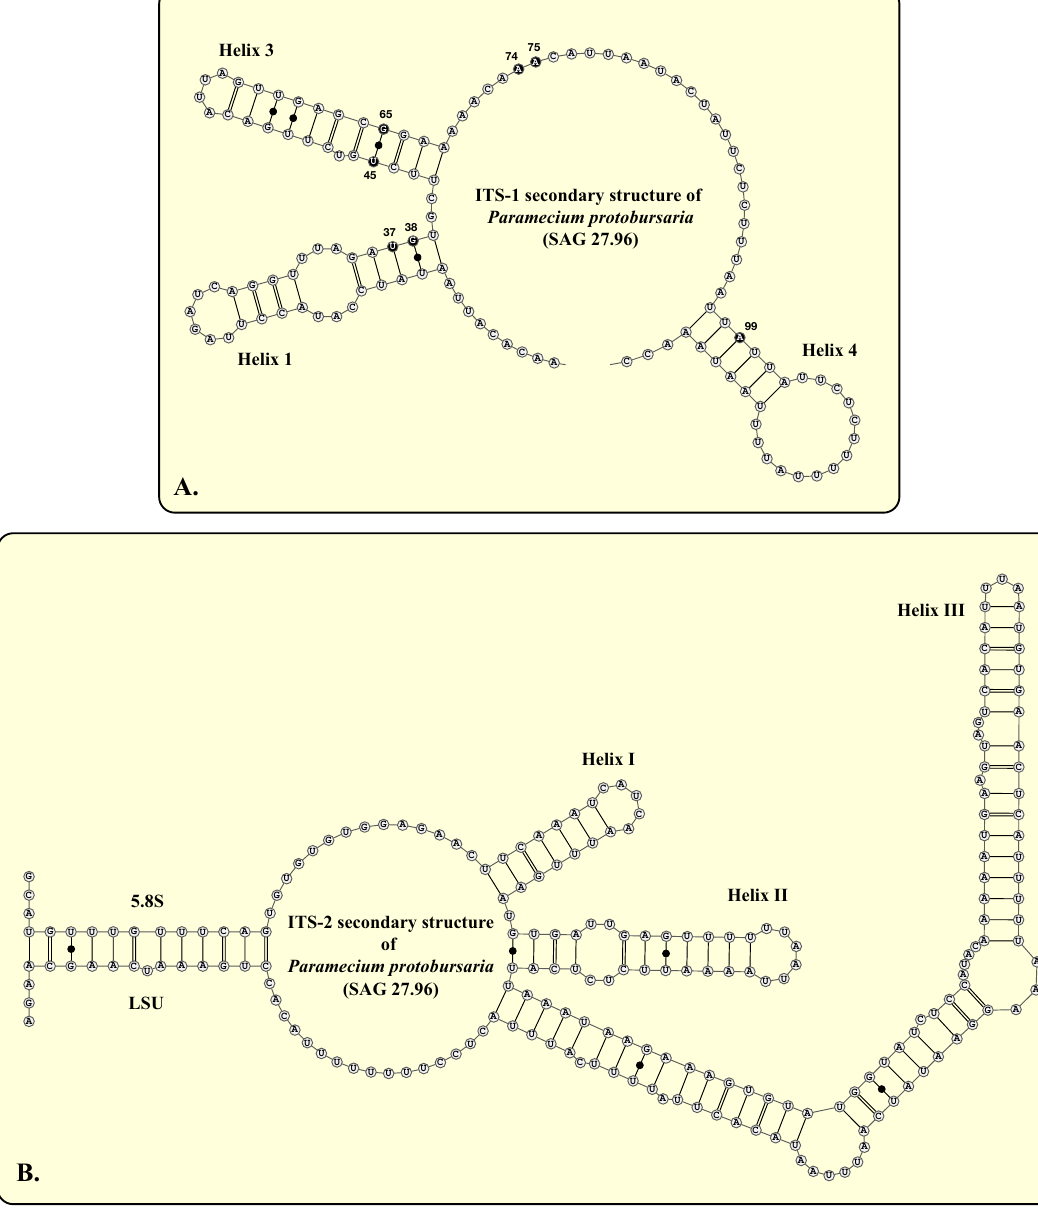
Figure 1. ITS ‐ 1 ( A ) and ITS-2 ( B ) secondary structures of Paramecium protobursaria , SAG 27.96 (syngen micronucleus measures 11–20 × 5–8 µm; the usually two (rarely one) contractile vacuoles, one in the anterior and one in the posterior cell portion have radial collecting channels and 1–3 excretory pores each; the number of ciliary rows/20 µm is 14–22; the length of the caudal cilia is 9–19 µm; the numerous trichocysts located in the cell cortex are 4–6 µm in length. The symbiotic algae belong to M. conductrix ; the larger algae measure 4–7 × 4–7 µm; the smaller algal cells measure 2–5 × 2–5 µm. Geographic distribution : The investigated strains of syngen R1 were found in Europe: Göttingen, Germany; Lake Mondsee, Austria. In addition, this species has been reported from different places in Europe, Asia and North America (see details in Supplementary Table 1). Reference material : Strain SAG 27.96 and the clonal strain SAG 2645 derived from SAG 27.96 are available at the Culture Collection of Algae (SAG), University of Göttingen, Germany. Holotype : Two slides (one holotype, one paratype) with protargol-impregnated specimens from the clonal culture SAG 2645, which derived from the reference material SAG 27.96, isolated from the pond of the Old